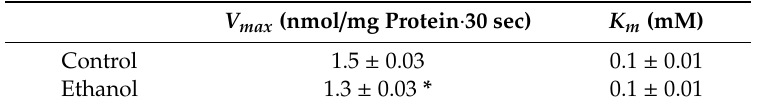
Table 2. The effect of moderate ethanol on the kinetic parameters of sodium-dependent glutamine co-transport in IEC-18 cells. Sodium-dependent glutamine uptake was conducted using varying concentrations of glutamine with and without a sodium-free condition in the presence and absence of moderate ethanol exposure for one-hour. Uptakes were conducted over thirty seconds. The maximal rate of uptake ( V max ) of sodium-dependent glutamine co-transport was significantly reduced when exposed to one-hour of ethanol (* p < 0.01, n = 4). There was no significant change in K m ( p > 0.05, n = 4).